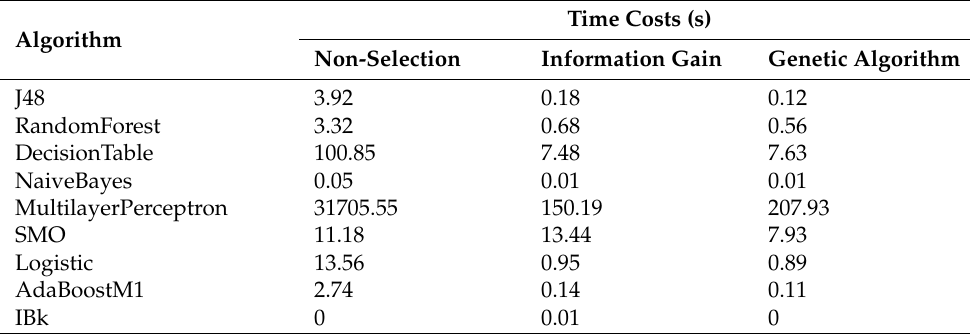
Table 5. The time cost for building a model for each